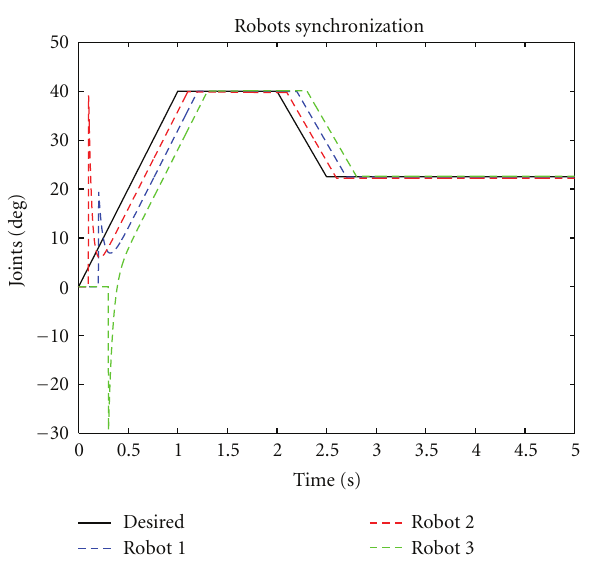
Figure 11: Robots synchronization in presence of time delay.